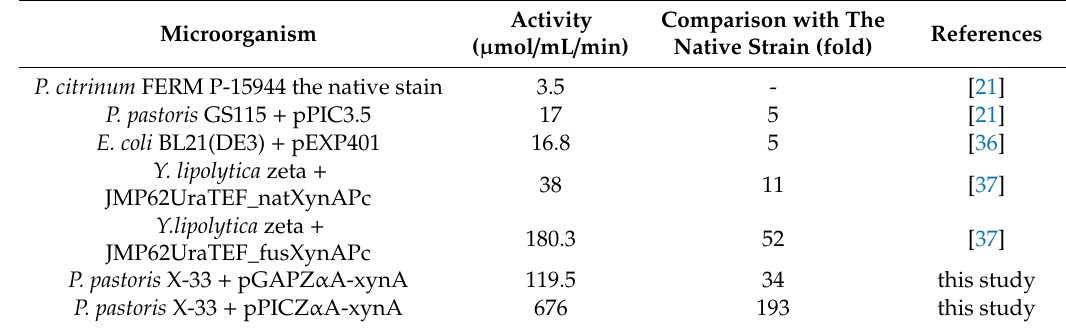
Table 1. Xylanase activity of XynA from P. citrinum in culture